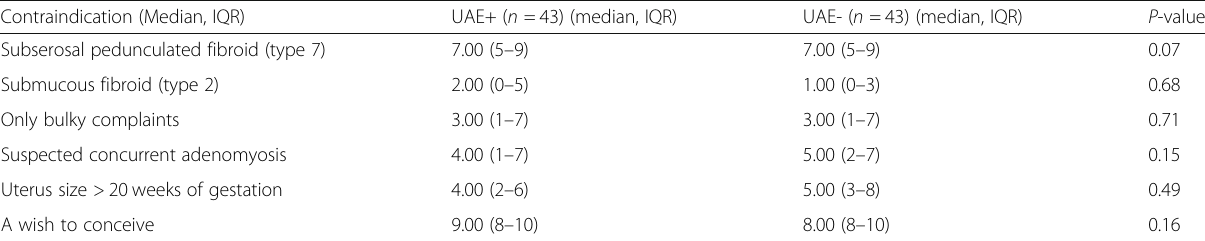
Median on a scale of 0 – 10; 0=no, it is no contraindication for UAE 10=yes, I it is a contraindication for UAE IQR Interquartile range P -value calculated with Mann-Whitney U